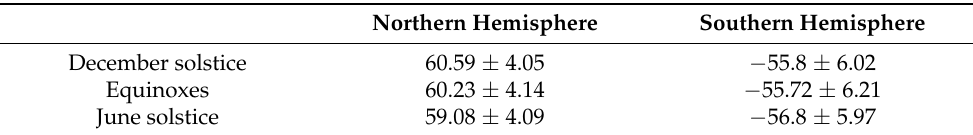
Table 2. Mean position of the trough minimum during December solstice, June solstice, and the equinoxes. The corresponding standard deviations are given after the ± sign.